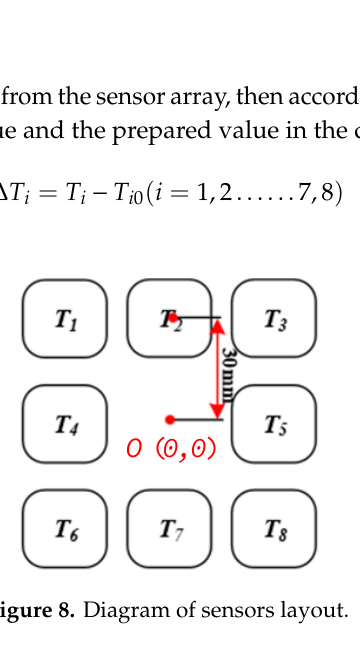
Figure 7. Fitting data of magnetic flux density in eight typical directions.